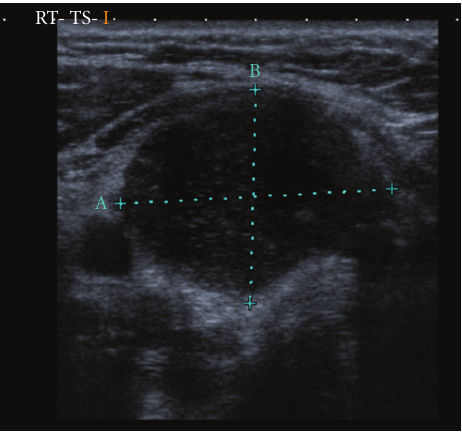
Figure 1: Cystic mass with internal echoes lying anterior to thyroid.